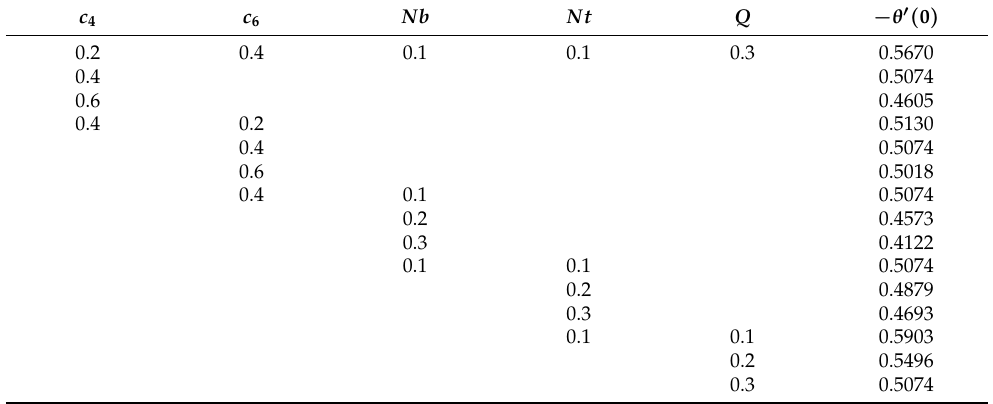
Table 3. Results for − θ (cid:48) ( 0 ) .